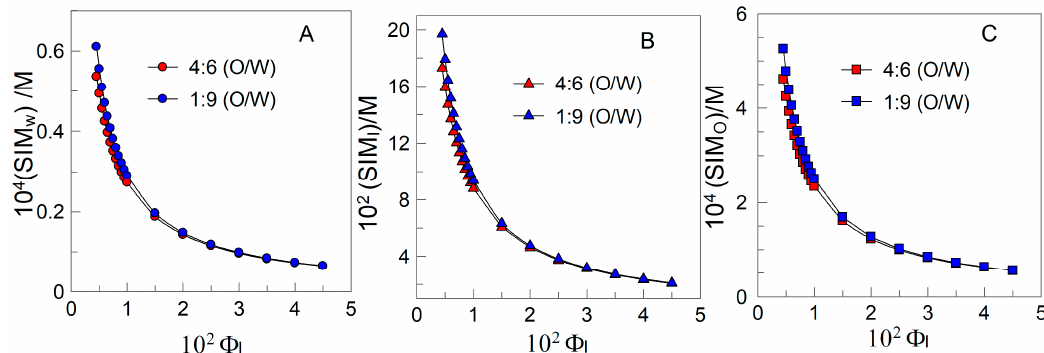
Figure 3. E ff ect of the emulsifier volume fraction ( Φ I ) on the e ff ective local concentrations of SIM-53B